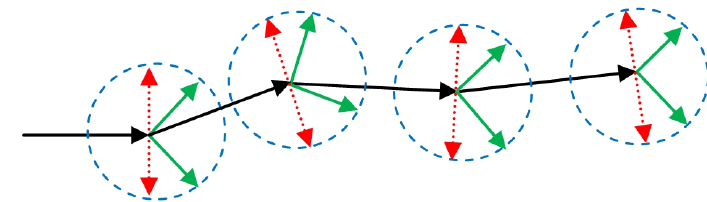
Figure 9. The example of the third constrain conditions.